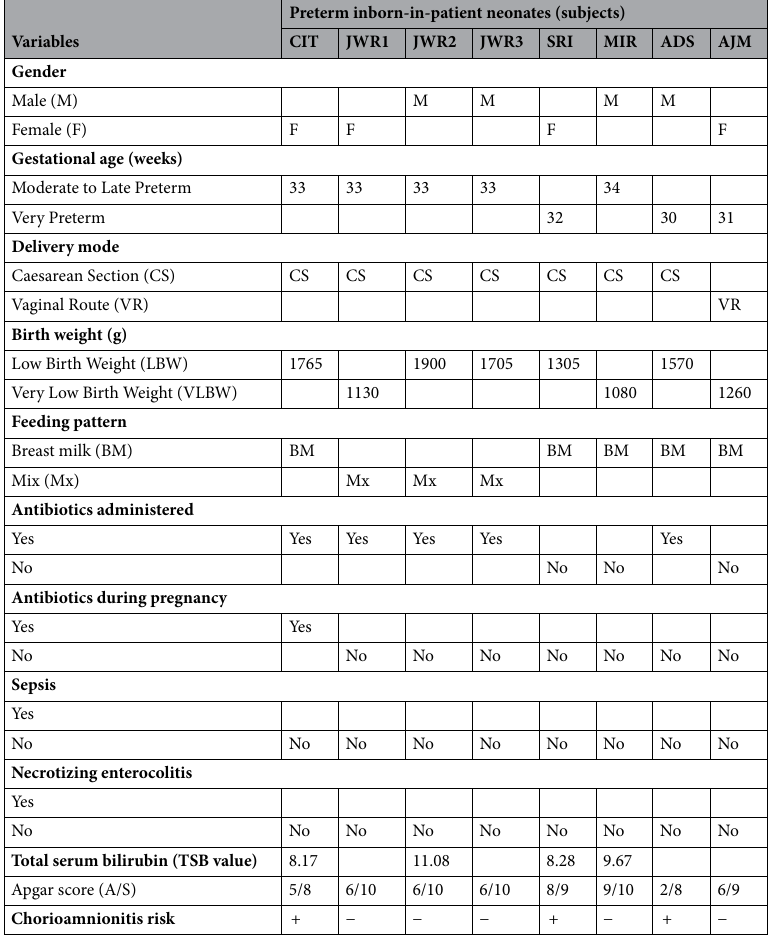
Table 1. Characteristic of preterm inborn in-patient neonates in this